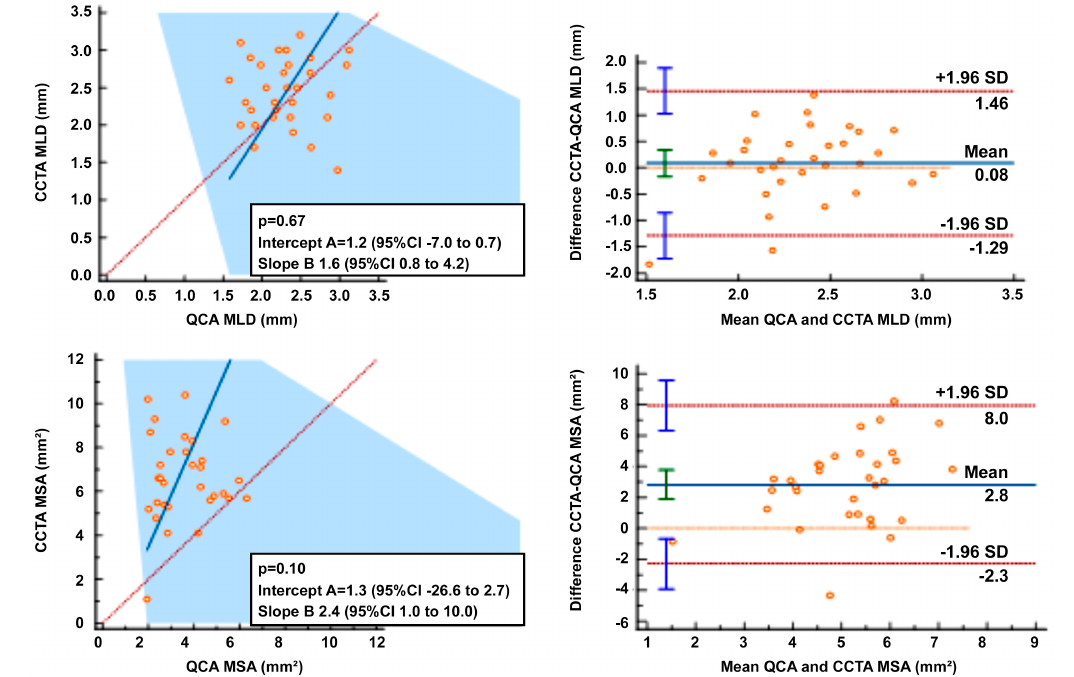
Figure 5. Quantitative Coronary Angiography (QCA) and Coronary Computed Tomography An- giography (CCTA) correlation and agreement. Passing-Bablok regression analyses on the left and Bland-Altman analyses on the